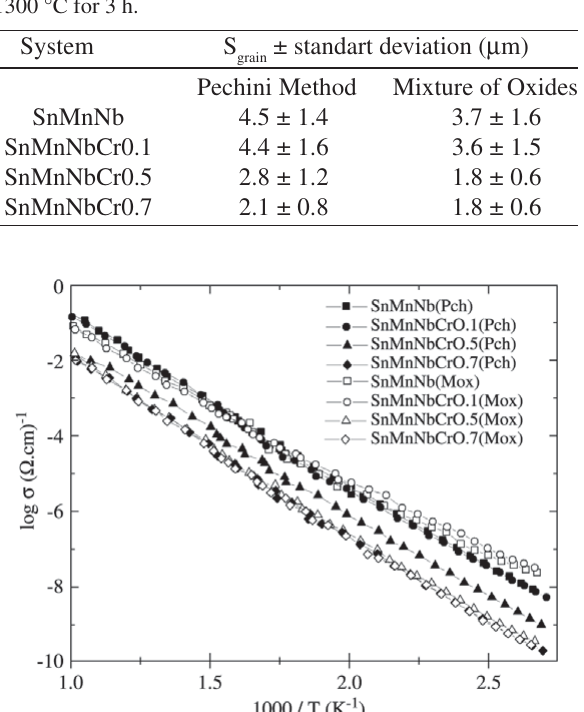
/ µ m) of systems sintered at grain